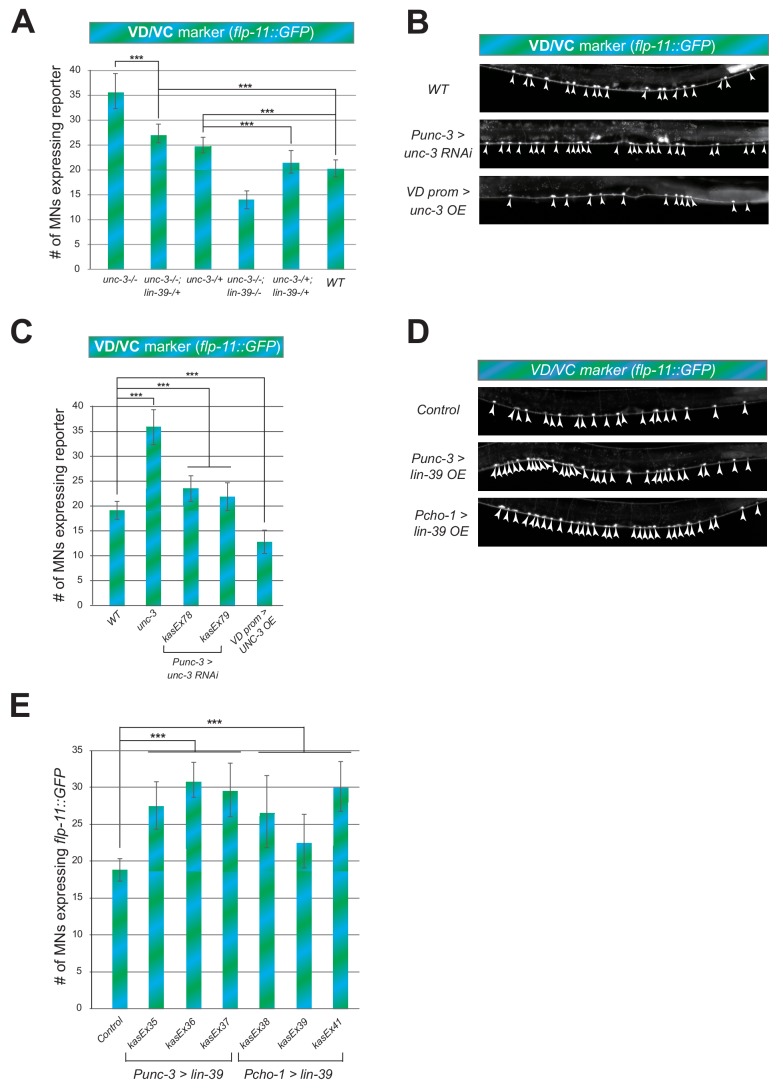
UNC-3 and LIN-39 levels are crucial for ectopic expression of VD/VC terminal identity marker flp-11.(A) Quantification of the VD/VC marker flp-11::gfp in unc-3 (n3435), unc-3 (n3435); lin-39 (n1760)/+, unc-3 (n3435)/+, unc-3 (n3435); lin-39 (n1760), unc-3 (n3435)/+; lin-39 (n1760)/+, and WT animals at L4. N > 18. ***p<0.001. (B): Representative images of the VD/VC marker flp-11::gfp expression in L4 stage WT or transgenic animals that either down-regulate unc-3 in cholinergic MNs (Punc-3 >unc-3 RNAi) or over-express unc-3 in GABAergic (including VD) neurons (Punc-47 >unc-3 OE). Arrowheads point to MN cell bodies with gfp expression. Green fluorescence signal is shown in white for better contrast. (C) Quantification of data shown in panel B. Two independent transgenic lines were used for Punc-3 >unc-3 RNAi. N > 17. ***p<0.001. Quantification of flp-11::gfp is also shown in WT and unc-3 (n3435) null animals for comparison. (D) Representative images of the VD/VC marker flp-11::gfp expression in L4 stage WT or transgenic animals that over-express lin-39 in cholinergic MNs driven by two different cholinergic MN promoters(Punc-3 >lin-39 OE, Pcho-1 >lin-39 OE). Arrowheads point to MN cell bodies with marker expression. Green fluorescence signal is shown in white for better contrast. (E) Quantification of data shown in panel D. Three independent transgenic lines were used for Punc-3 >lin-39 OE and Pcho-1 >lin-39 OE. N = 19. ***p<0.001.